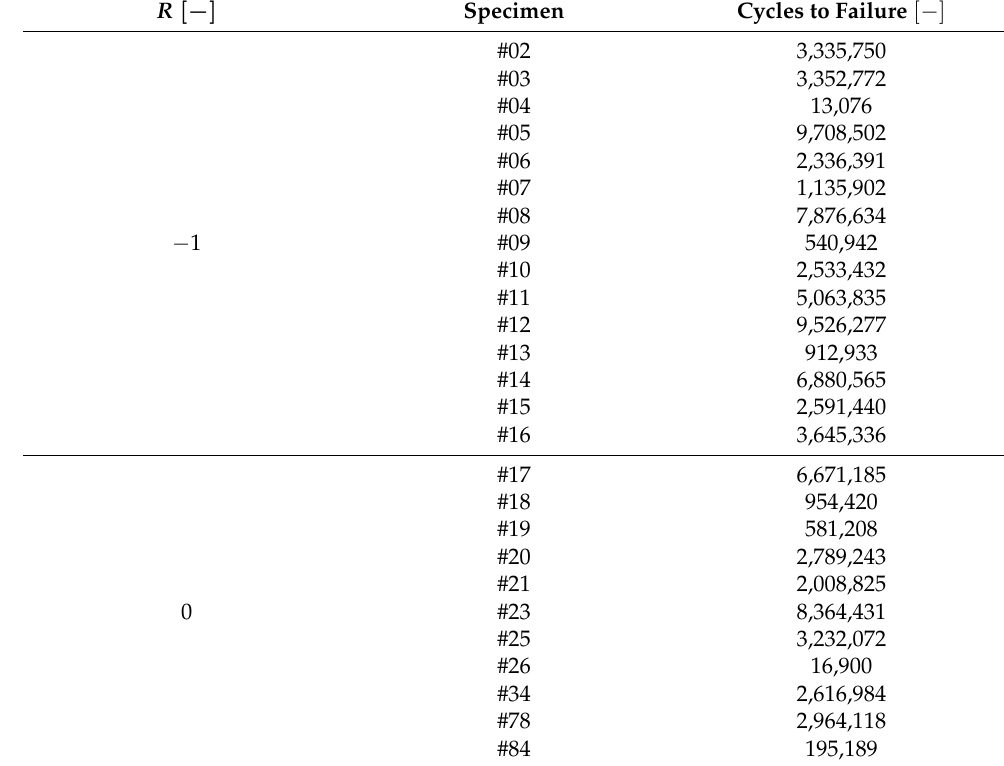
Table 6. Number of load cycles to burst